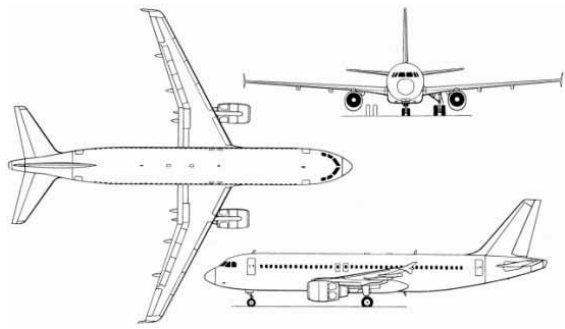
Fig. 2. AIRBUS A 320. Three view drawing and technical